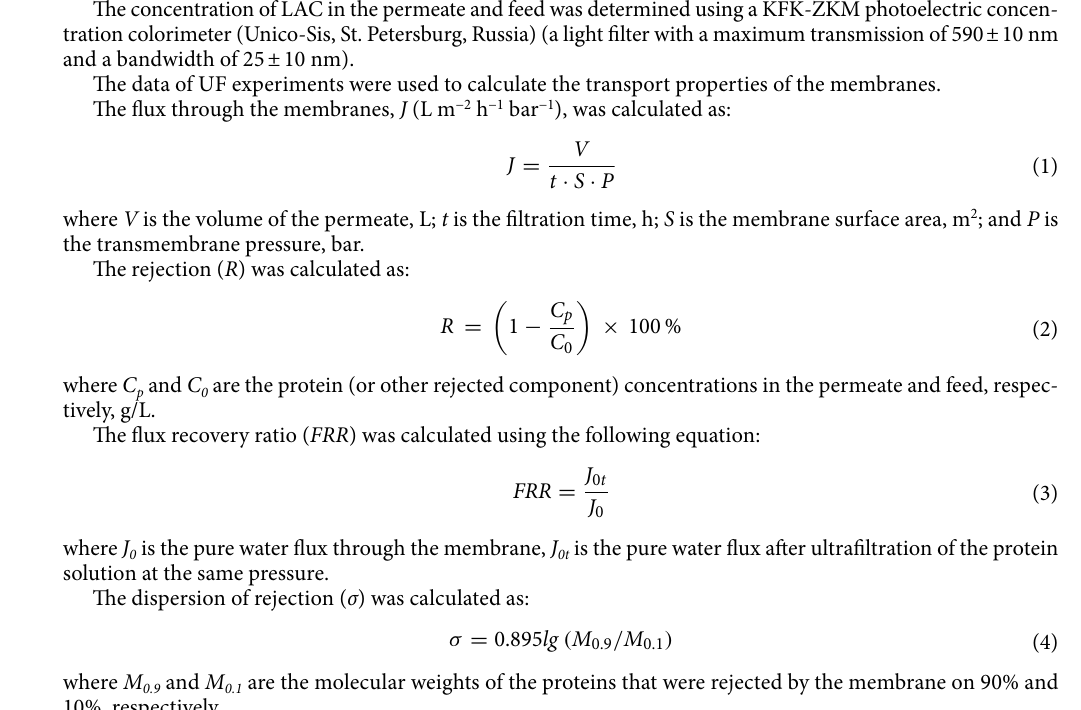
where M 0.9 and M 0.1 are the molecular weights of the proteins that were rejected by the membrane on 90% and 10%, respectively.